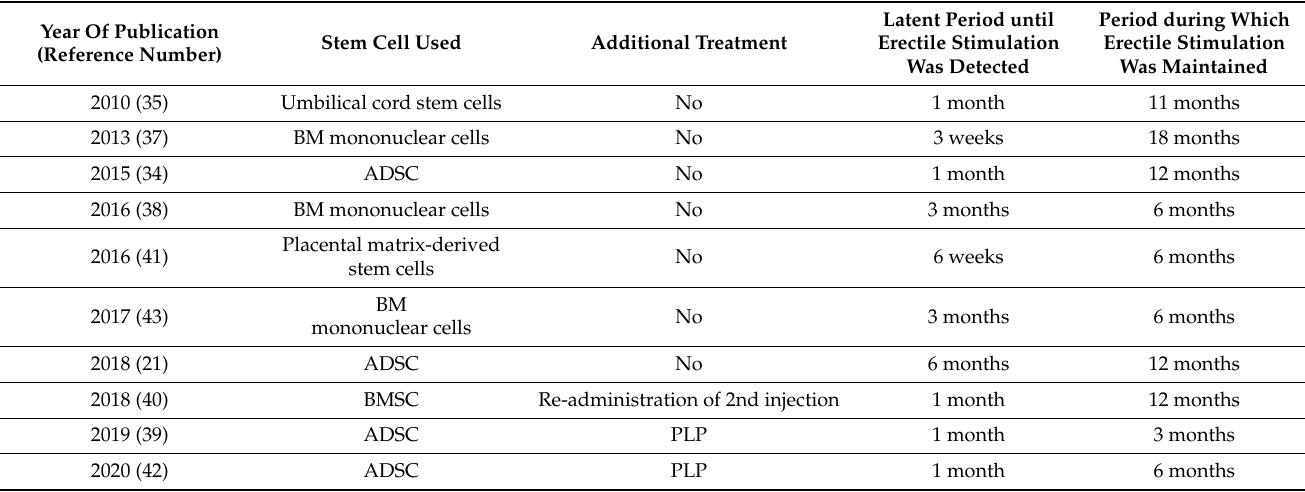
Table 1. Overview of clinical